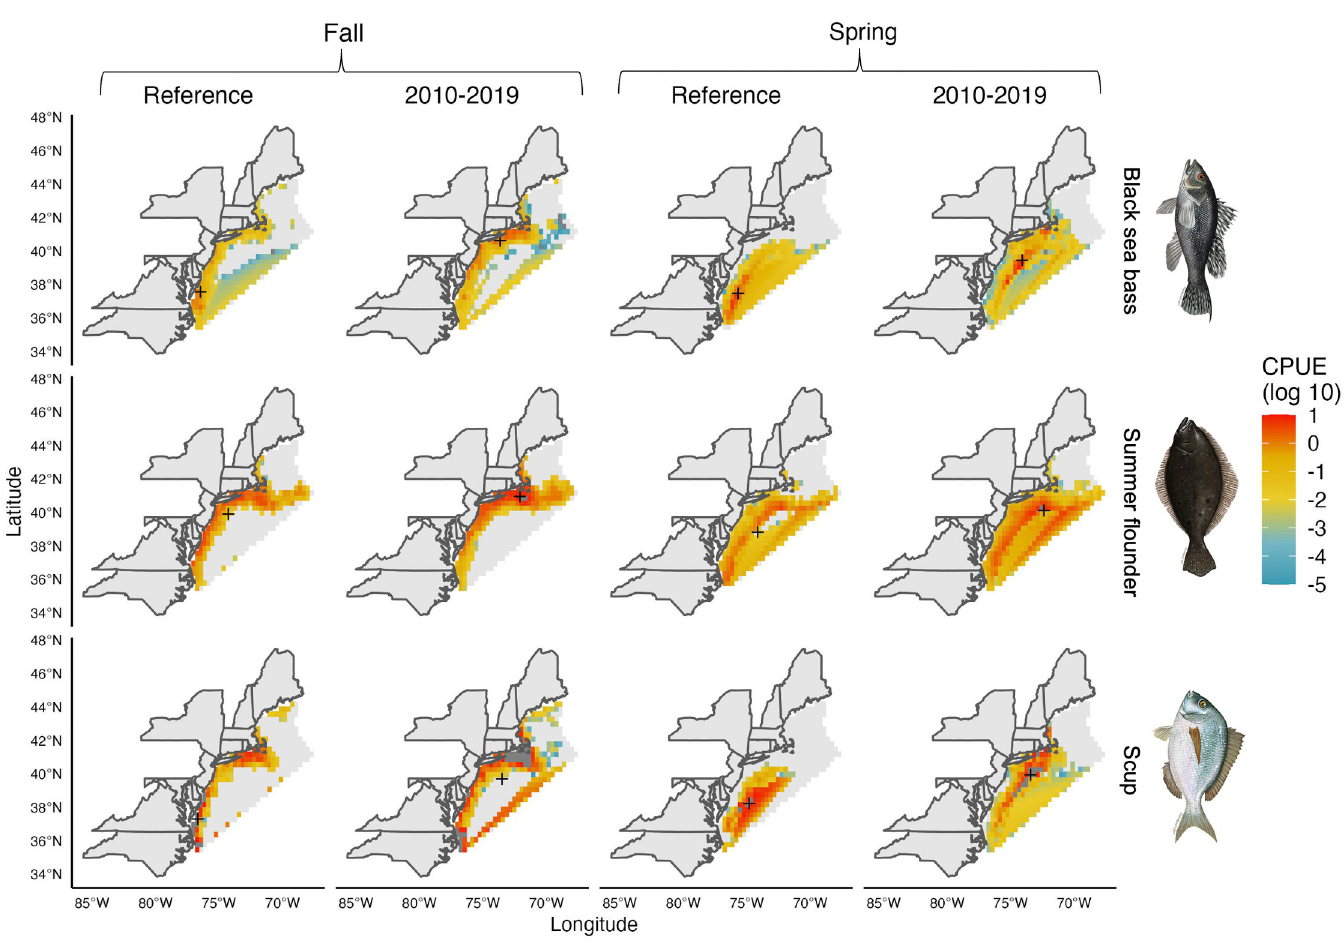
Fig 3. Interpolation results for all species and seasons within the US Northeast Exclusive Economic Zone. Scale showing the trawl survey data as Catch per Unit of Effort (CPUE) at a log 10 scale. Black cross represents the species’ region with the largest CPUE with grey regions representing no CPUE. Reference period is related to the quota allocation period for each stock (see methods). Fish images from MAFMC